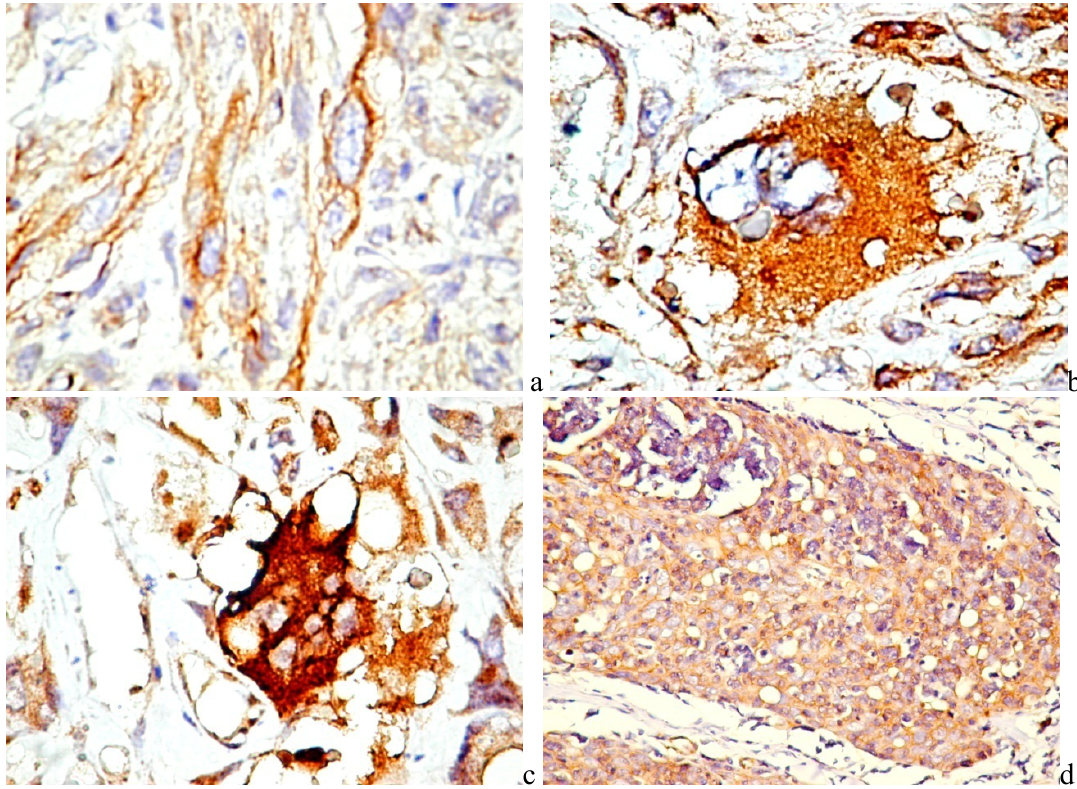
Figure 2. PDGF immunohistochemical expression in leiomyosarcoma (a, ×400), anaplastic renal cell carcinoma (b, ×400), malignant fibrous histiocytoma (c, ×400), and thymoma (d,